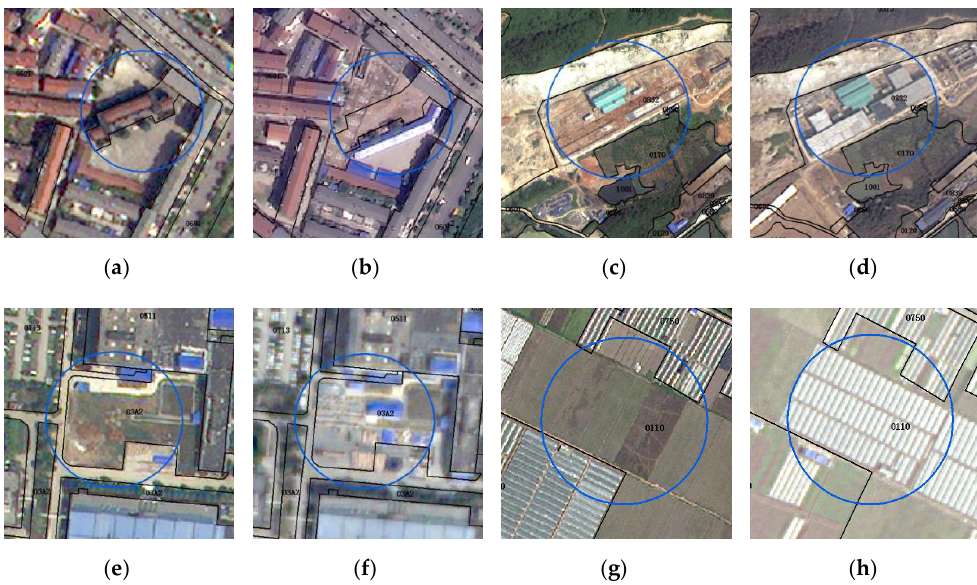
Figure 13. The circled polygons are changed objects missed by a cartographer but detected by the algorithm. From ( a – f ), the cartographer slipped up probably due to the complex environments and unobtrusive changes; in ( g ) and ( h ), the mistake is caused by obsolescence of knowledge: before 2016 green house is classified to crop land but thereafter is classified to constructions according to the rule of China's first national geoinformation survey.